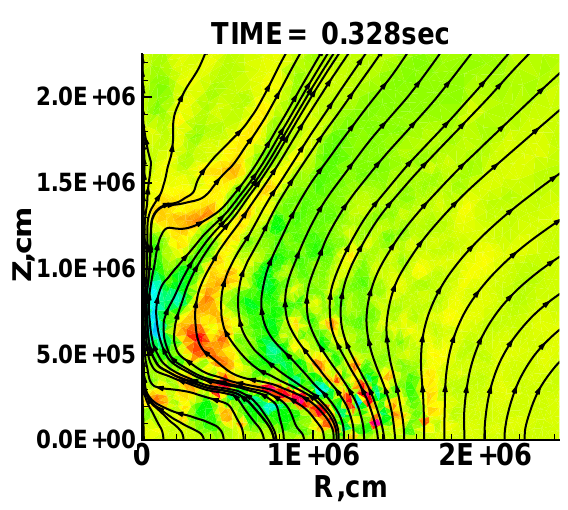
Figure 12: Absence of MDRI at t = 328ms for the case H 0 = 10 12 G , E rot 0 /E grav 0 = 1% (contour plot - the toroidal magnetic field, arrow lines - force lines of the poloidal magnetic field).